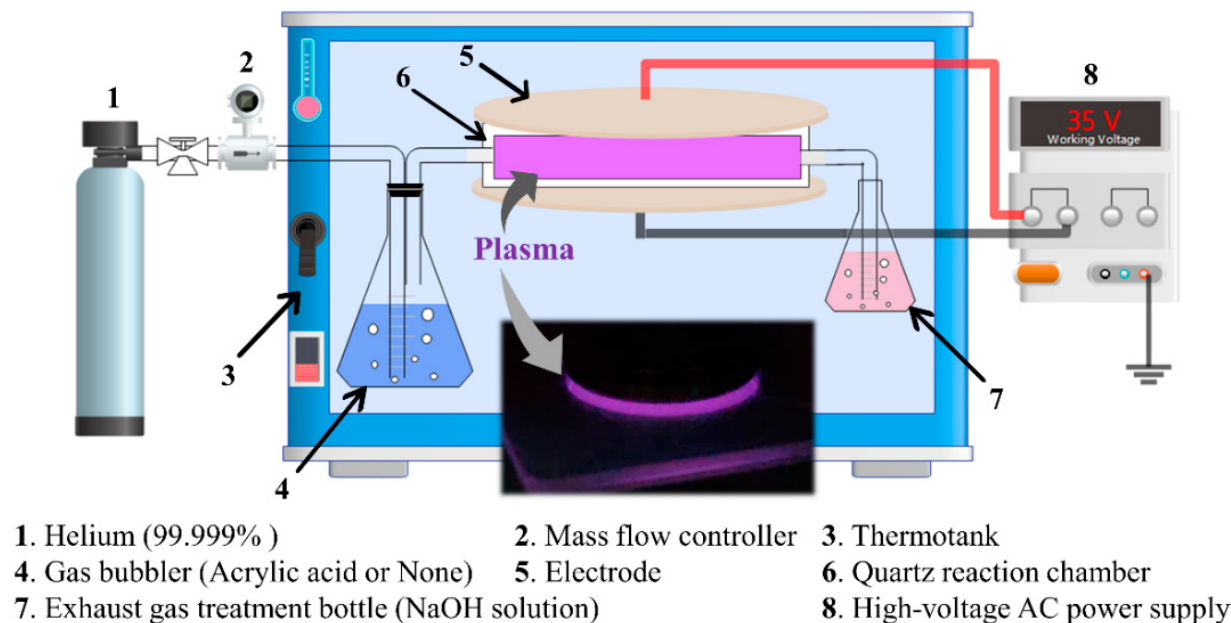
Figure 1. Atmospheric-pressure DBD plasma experimental device.